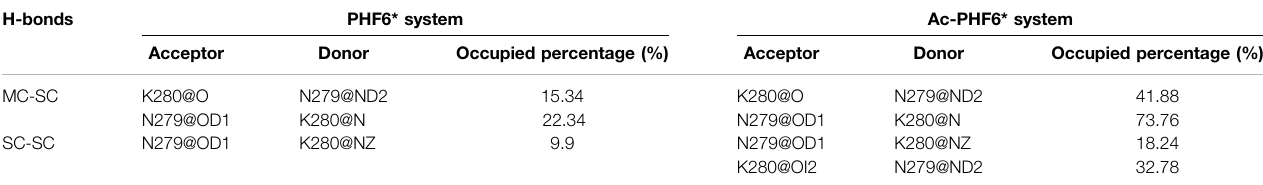
Figure 6A , in the PHF6* system, the sidechain of Q276 and N279 forms more H-bonds with the mainchain of N279/K280 and V275/I277, respectively. K280 acetylation affects the MC-SC